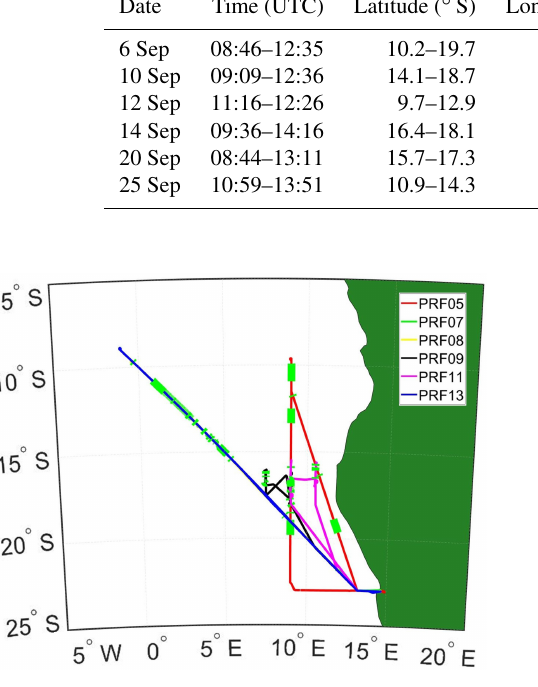
Figure 8. Flight tracks from PRFs 5, 7, 8, 9, 11, and 12 flown on 6, 10, 12, 14, 20, and 25 September 2016 with green segments in- dicating location of cloud profiles (flight tracks from PRFs 7 and 8 coincide with PRF13 and hence are not visible).